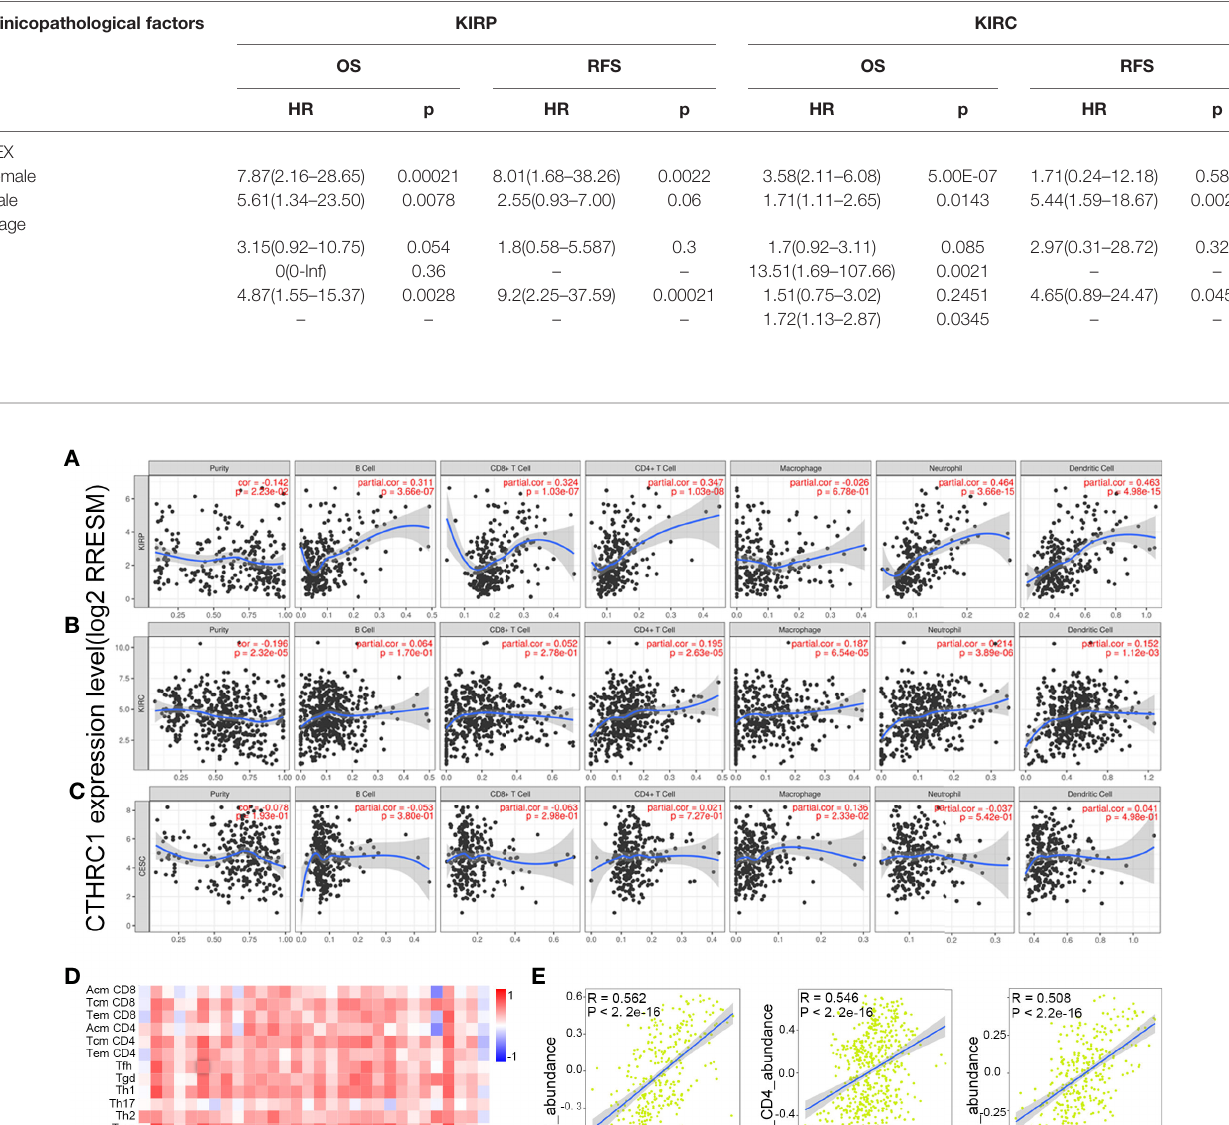
TABLE 1 | Correlation of CTHRC1 mRNA expression and prognosis in KIRP and KIRC with different clinicopathological factors by Kaplan-Meier